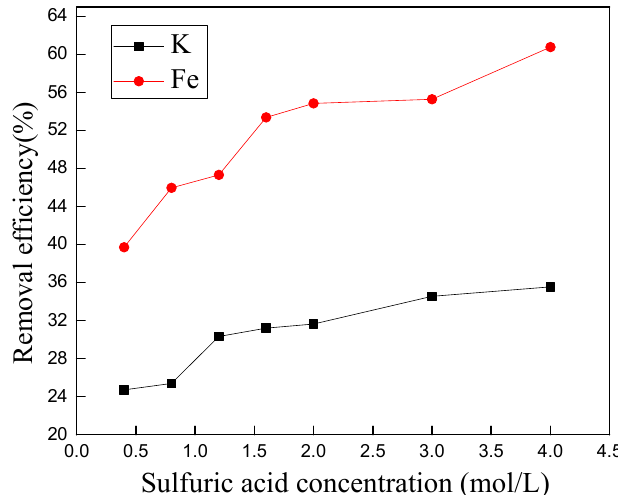
Figure 7. Effect of sulfuric acid concentration on the removal efficiency.